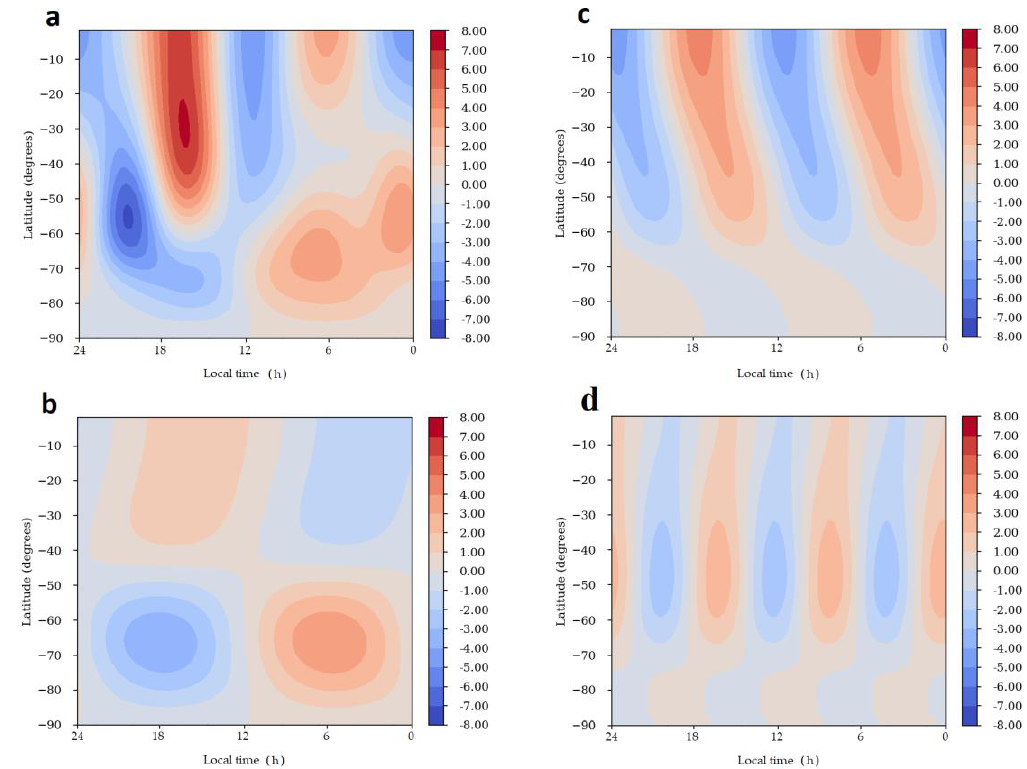
Figure 9. Horizontal structure at 5 × 10 2 Pa (80 km): ( a ) temperature anomaly field (K); ( b ) first harmonic of the temperature anomaly field (K); ( c ) second harmonic of the temperature anomaly field (K); ( d ) third harmonic of the temperature anomaly field (K).